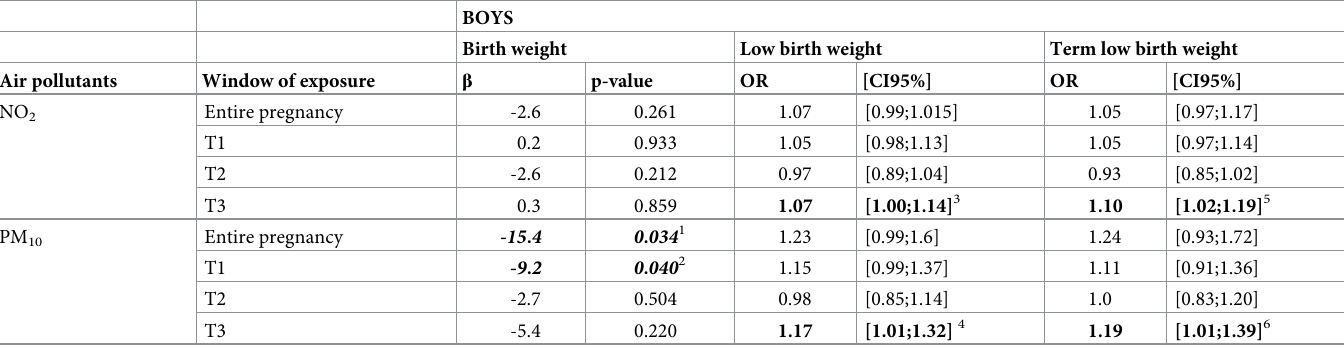
of the magnitude of associations ( β s and ORs), p-values, critical windows of exposure (T1, T2, T3 and entire pregnancy) and outcomes (BW, LBW and TLBW). Birth weight. Among female infants, the only two significant findings are the reduction of BW by 4.8 grams (p-value < 0.019) and 8.8 grams (p-value < 0.028) during the second